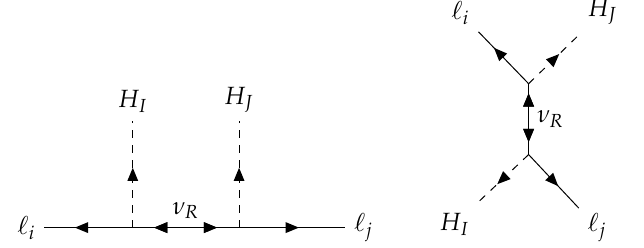
Figure 2. Matching contributions to the Weinberg operator in type I seesaw.